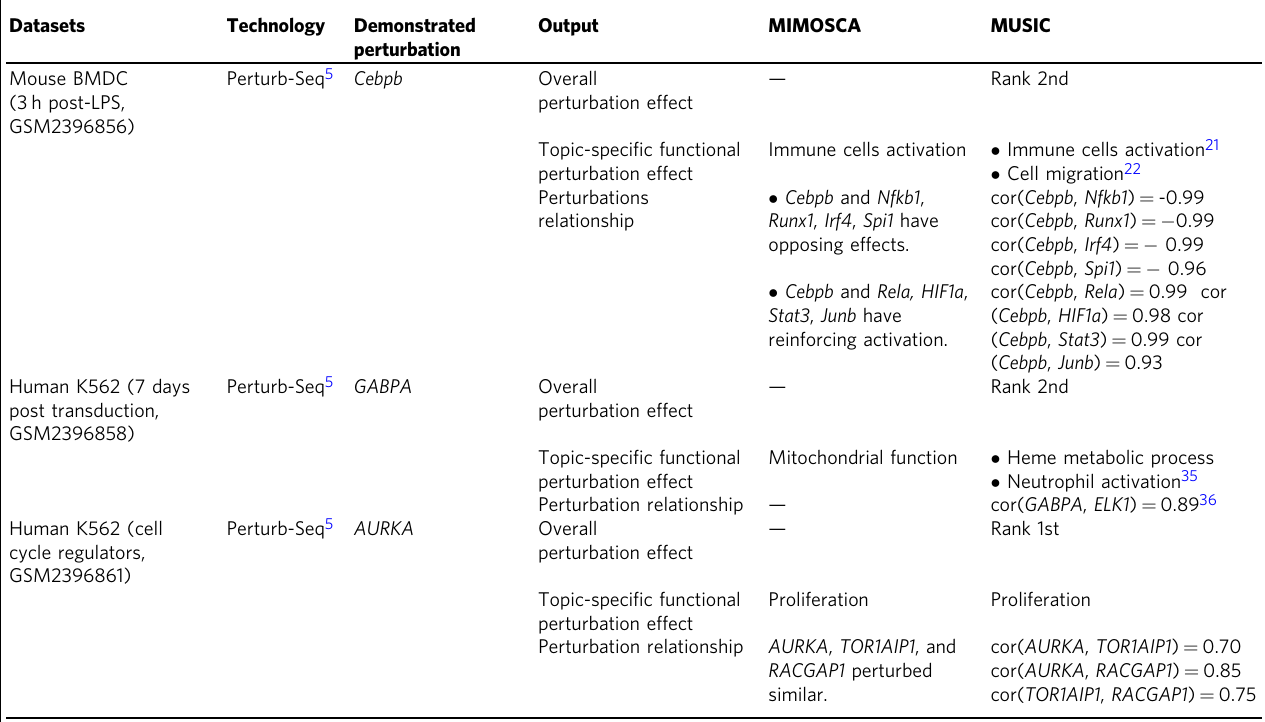
cor( a , b ) represents the Pearson correlation coef fi cient of topic distribution pro fi le between perturbation a and perturbation